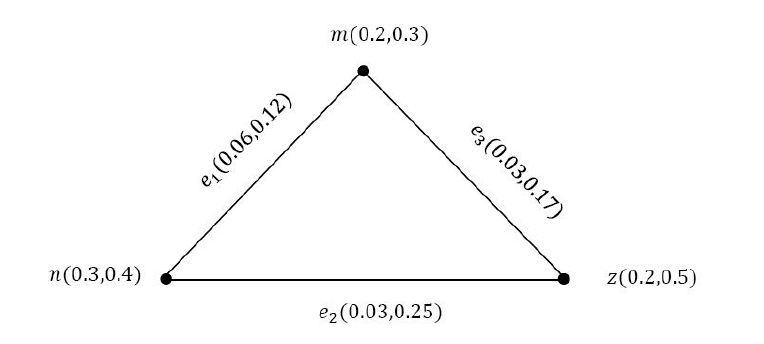
Figure 4. Product vague graph ζ